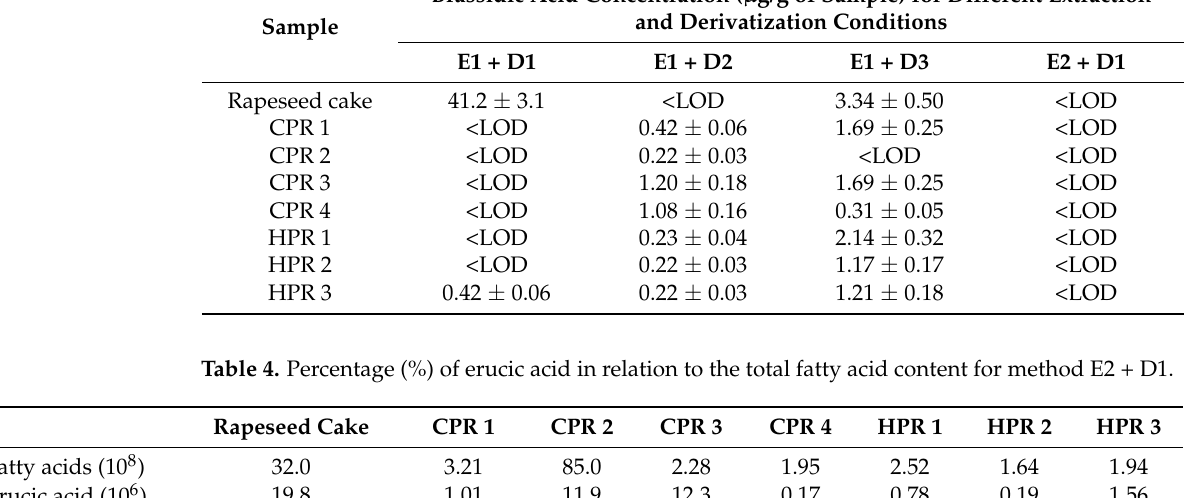
Table 3. Quantity of brassidic acid ( µ g/g of sample) in rapeseed cake and protein products CPR1- 4 and HPR 1–3 for different extraction (E) and derivatization (D) methods (E1: Folch method,